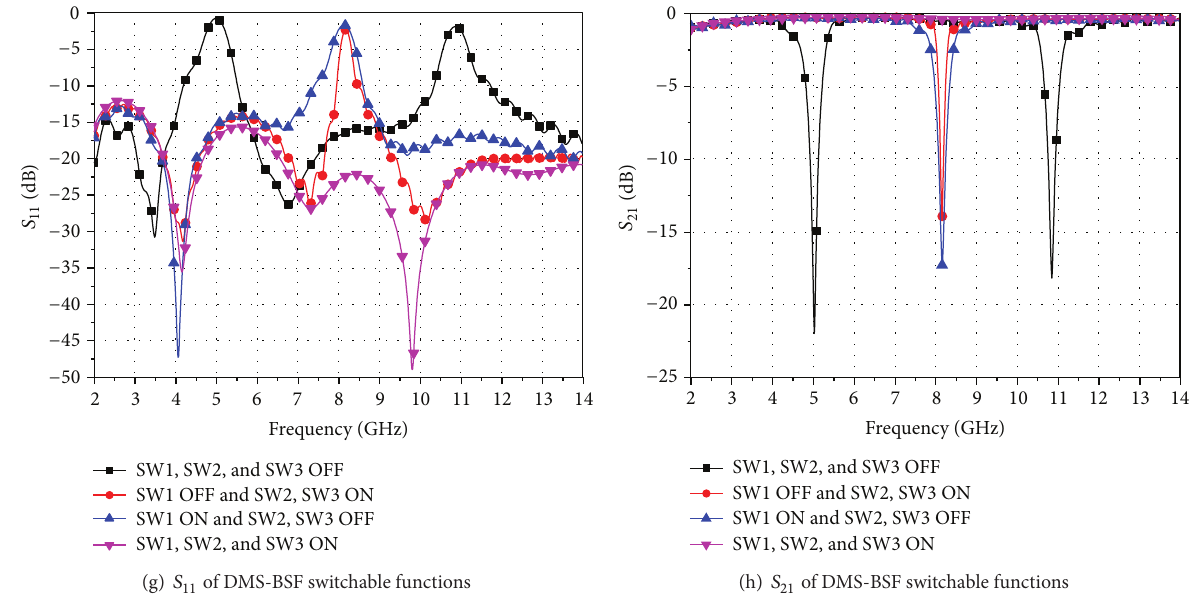
Figure 2: 𝑆 -parameters of